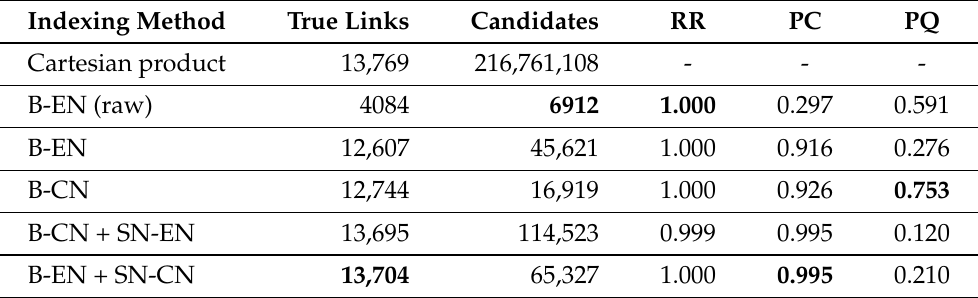
Table 3. Statistics for each tested variant of indexing measured on a training subset of the reduced dataset. The best values of each statistic are in bold. For the last two methods their best variants (window = 3) are